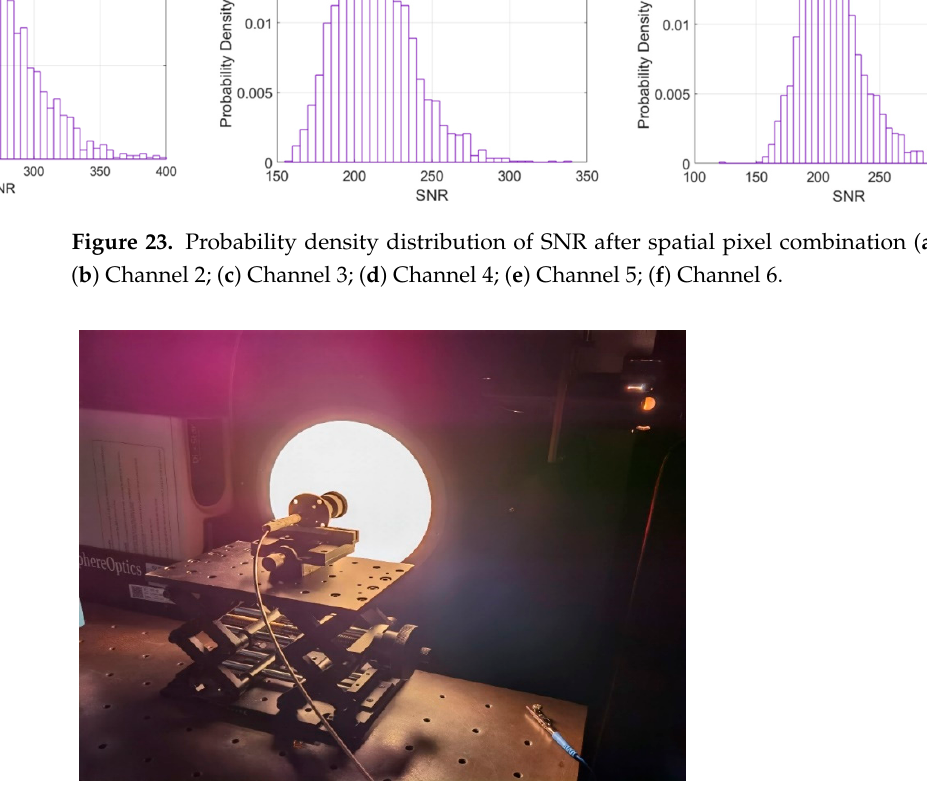
Figure 23. Probability density distribution of SNR after spatial pixel combination( a ) Channel 1; ( b ) Channel 2; ( c ) Channel 3; ( d ) Channel 4; ( e ) Channel 5; ( f ) Channel 6.